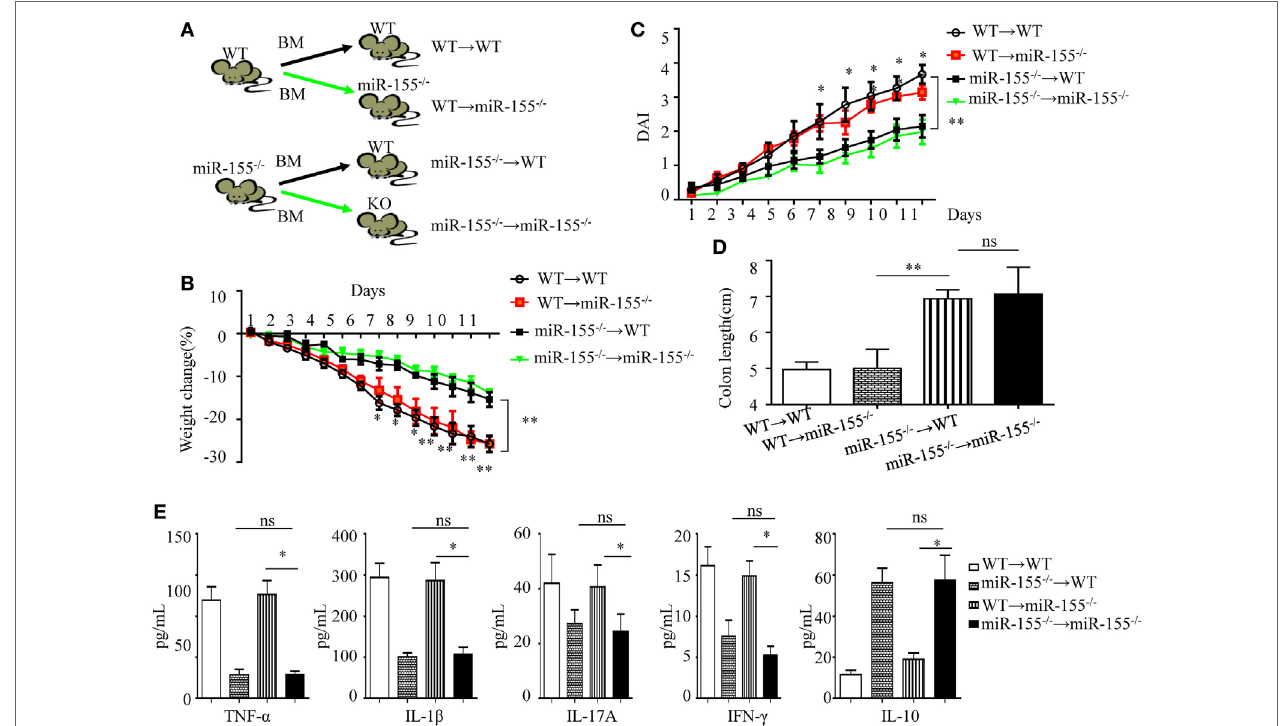
FigUre 2 | miR-155 deficiency ameliorates colitis by affecting inflammatory signaling in mucosal immune cells. The bone marrow chimeras were reconstructed and 7–8 weeks later treated with 3% dextran sulfate sodium as in Figure 1a . (a) Schematic of bone marrow chimera reconstructions. (B–D) Body weight (B) and DAI (c) were monitored daily, and colon length of each bone marrow chimeras was examined at day 11 (D) . (e) The cytokine concentrations in the supernatants of 24 h cultured colon explants were assessed by ELISA and were normalized by total colon tissue weight in whole-colon culture. * P < 0.05, ** P < 0.01, WT → miR-155 − / − mice vs miR-155 − / − → miR-155 − / − mice. ns, not significant, miR-155 − / − → WT mice vs miR-155 − / − → miR-155 − / − . Student’s t -test in (a–D) ; n = 11–14 per group. Data are representative of two independent experiments (mean and SD). BM, bone marrow; WT,